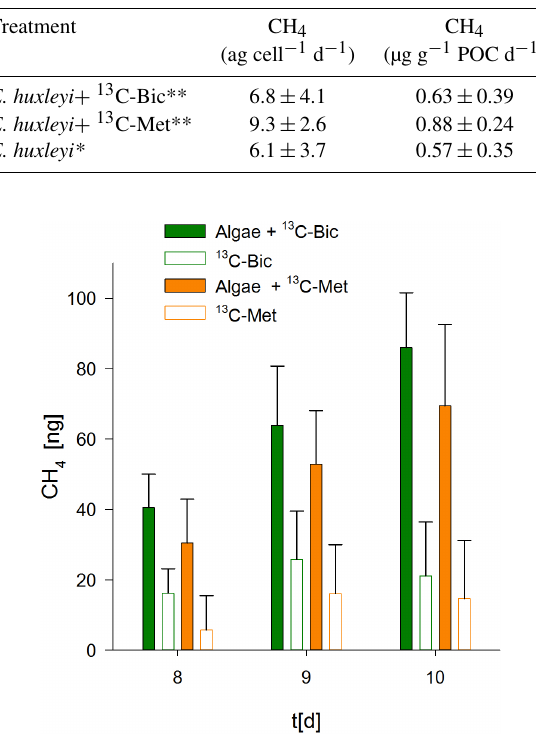
Figure 5. Mean CH 4 content (sum of headspace and water phase) in the flasks of E. huxleyi supplemented with either bicarbonate or methionine ( n = 3) or the respective control without algae ( n = 2) measured at days 8, 9 and 10; error bars show the standard devia-